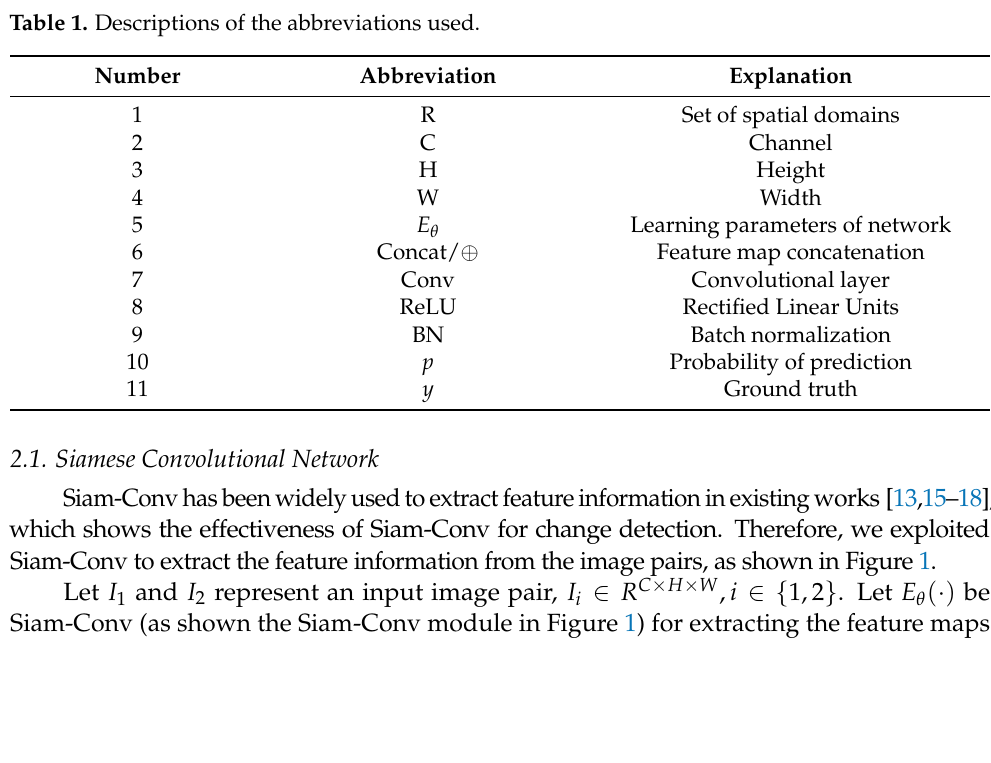
Table 1. Descriptions of the abbreviations